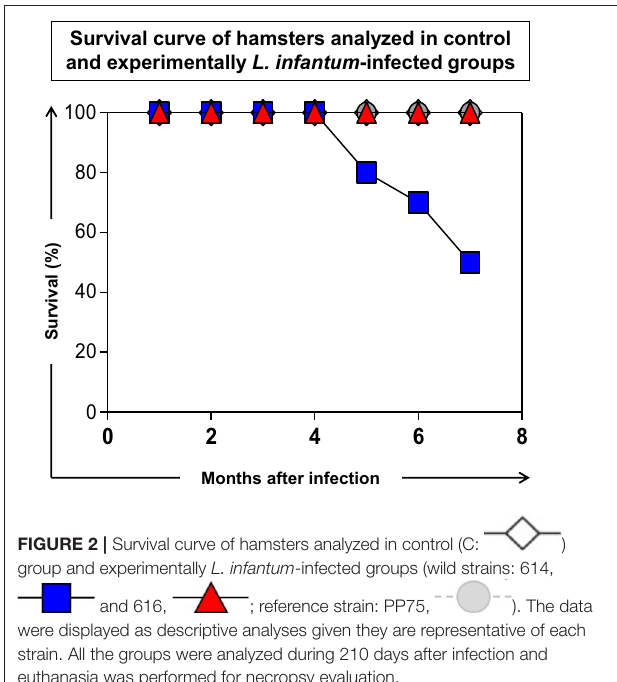
The measurements exhibited in the control group were used as reference values. Statistical differences were displayed as “a” and “b,” for the “C” and “PP75” groups, respectively. All data are shown as mean ± standard deviation.